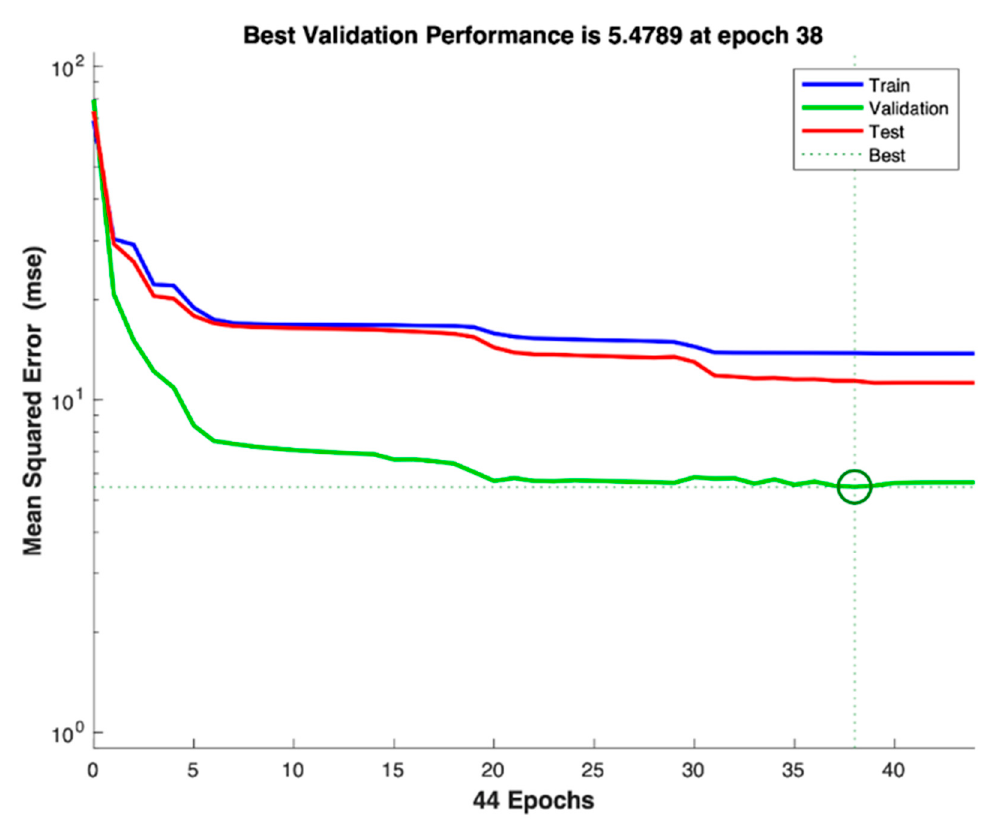
Figure 4. Number of iterations/epochs required for ANN model Figure 4 . Number of iterations/epochs required for ANN model training .